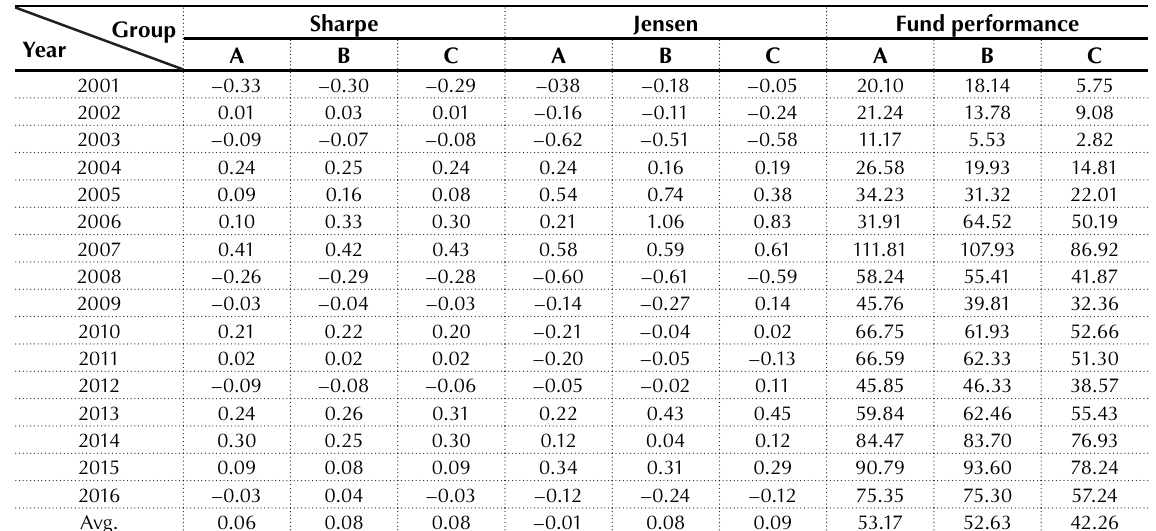
Table 3 contained fund performance statistics of Sharpe, Jensen and the rate of return since their establishment for the period 2001–2016, showing that Group A had lower performance than those from Group B and C and Group B is roughly in line with Group C according to Sharpe and Jensen indicators. The Sharpe indicator is used as an ex- ample to indicate the excess compensation per unit of the mutual fund linked to the investment Table 3. Fund performance comparison